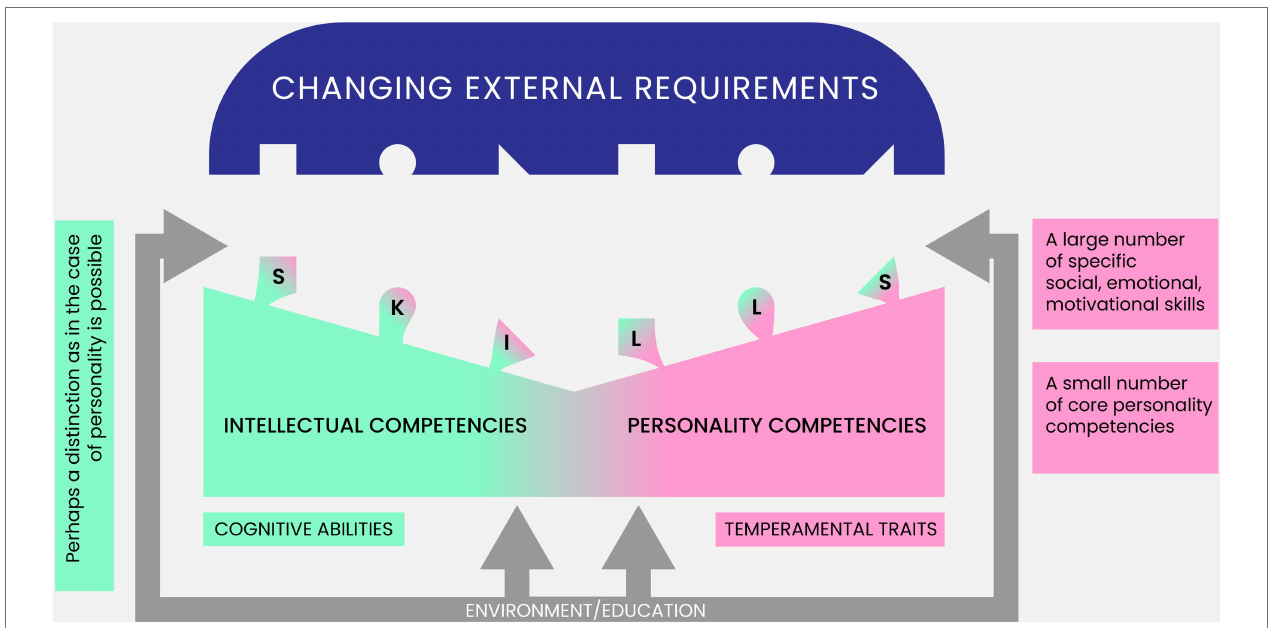
FIGURE 5 | A comprehensive model of competencies and skills both in cognitive and noncognitive